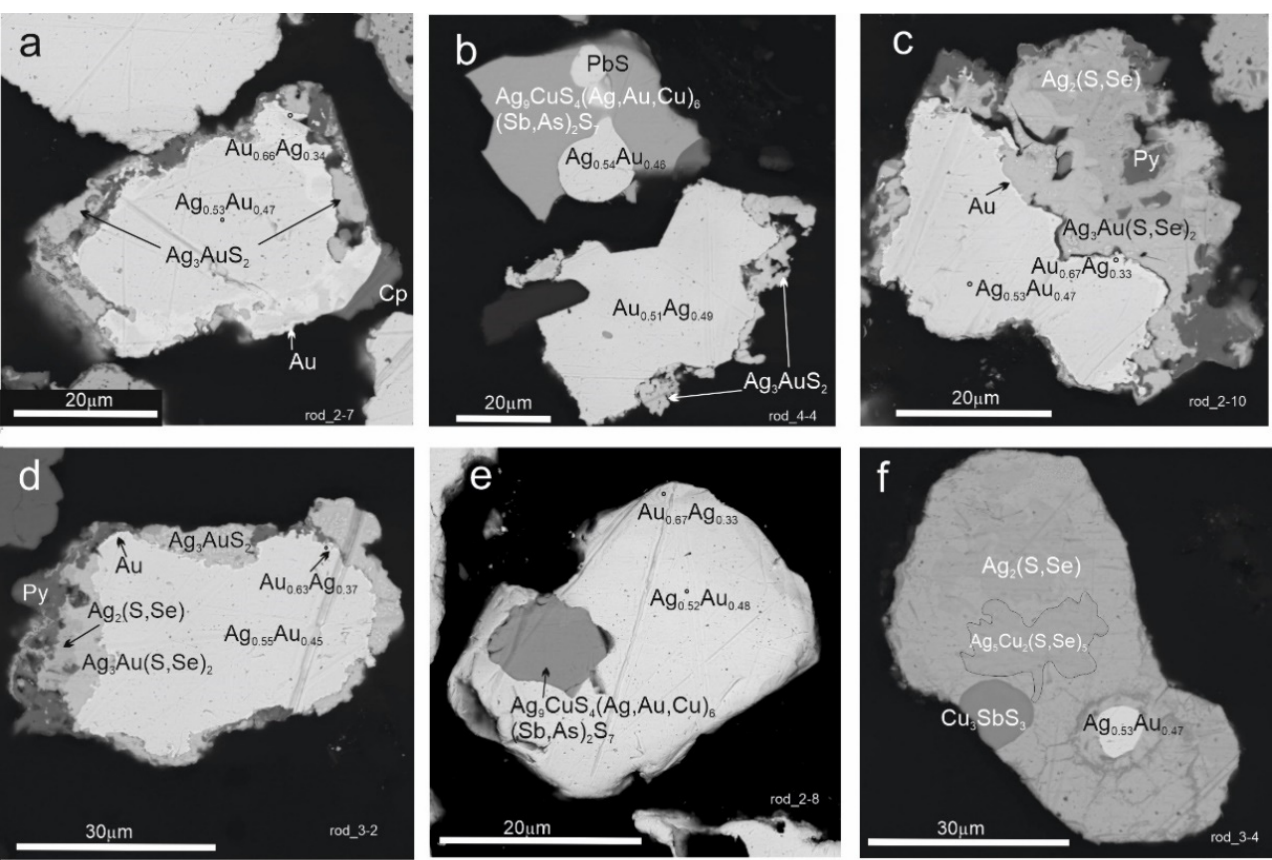
Figure 6. SEM-BSE images of ore concentrates from the Rodnikovoe deposit. The gold-uytenbogaardtite-acanthite assemblage: ( a , c , d ) Grains of Ag-Au alloy featuring thin rims of higher- grade gold, replaced by an aggregate of uytenbogaardtite Ag 3 Au(S,Se) 2 and acanthite Ag 2 (S,Se); ( b ) drop-shaped inclusions of galena (PbS) and Ag-Au alloy in polybasite